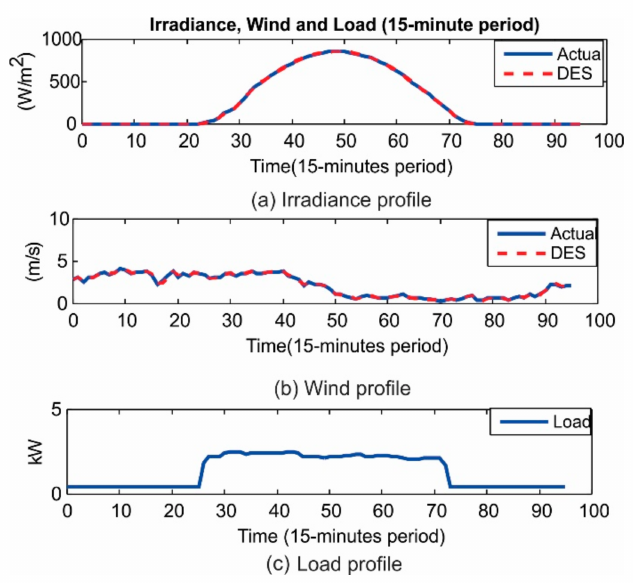
Figure 7. Forecasting curves for the testbed